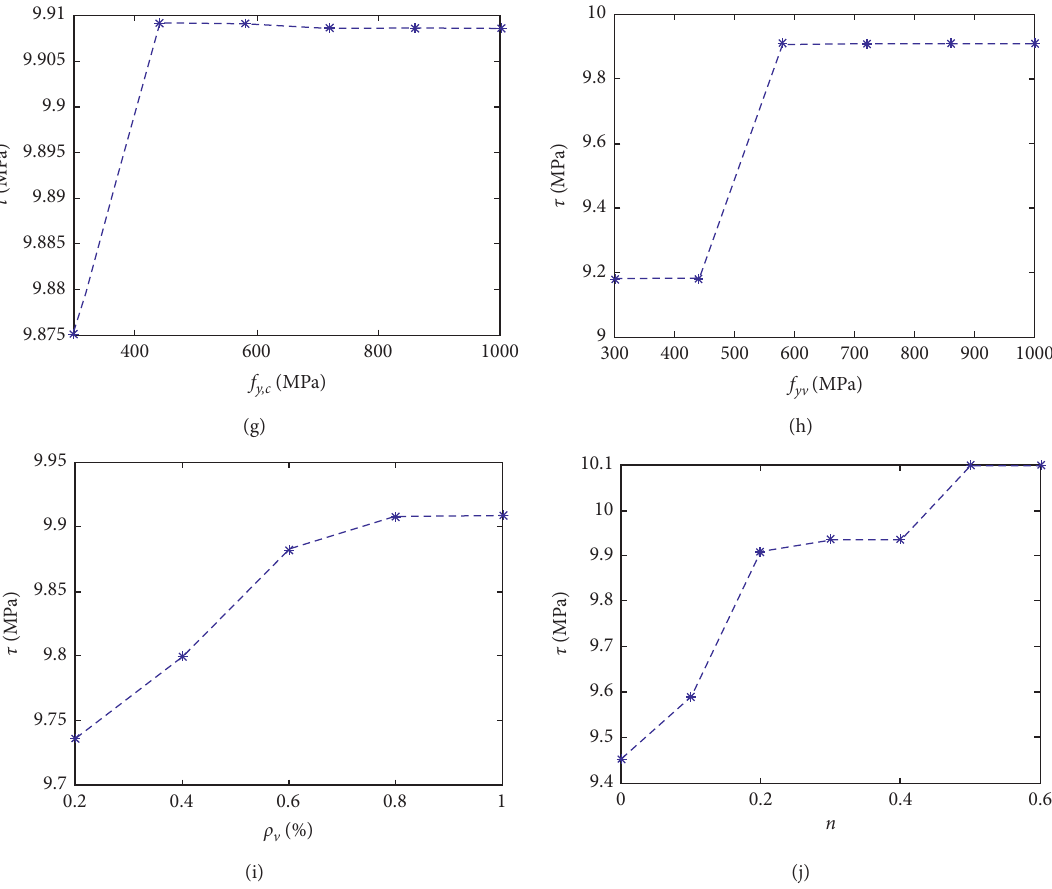
Figure 8: Prediction results of parametric analysis. (a) Concrete strength (MPa). (b) Section width of column (mm). (c) Section height of column (mm). (d) Section width of beam (mm). (e) Section height of beam (mm). (f) Yielding strength of beam longitudinal bar (MPa). (g) Yielding strength of column longitudinal bar (MPa). (h) Yielding strength of joint transverse bar (MPa). (i) Transverse bar ratio (%). (j) Axial load ratio.